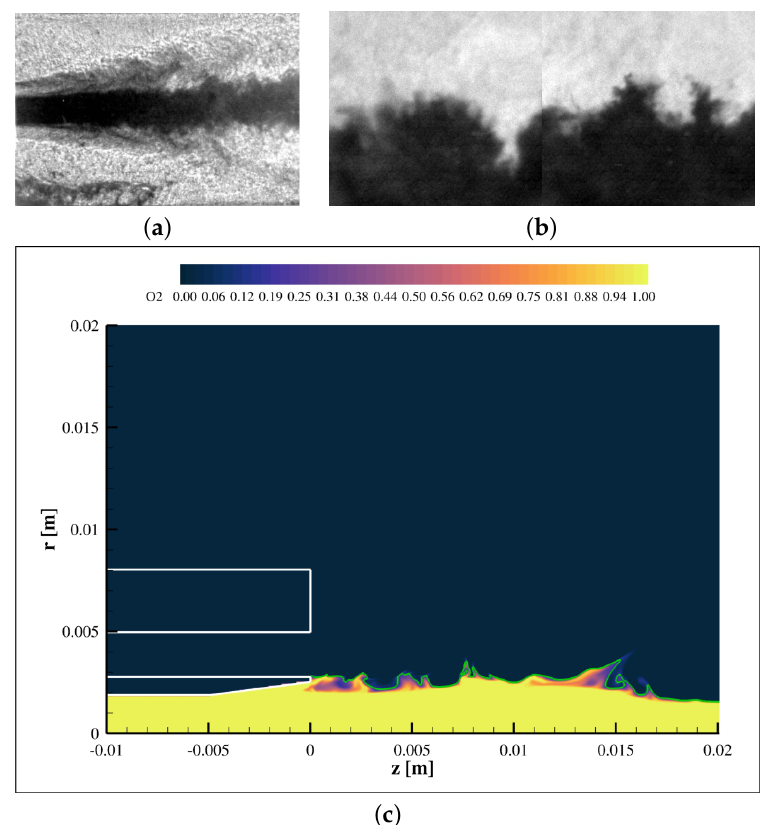
Figure 17. At the top, shadowgraphy ( a ) and back-lighting ( b ) experimental images showing a typical instantaneous structure of the liquid O 2 jet for the present investigated case [62]. At the bottom, numerical instantaneous distribution of the O 2 mass fraction ( c ) at the same time as Figure 9; the stoichiometric mixture fraction isoline Z = 0.11 is also shown in green.